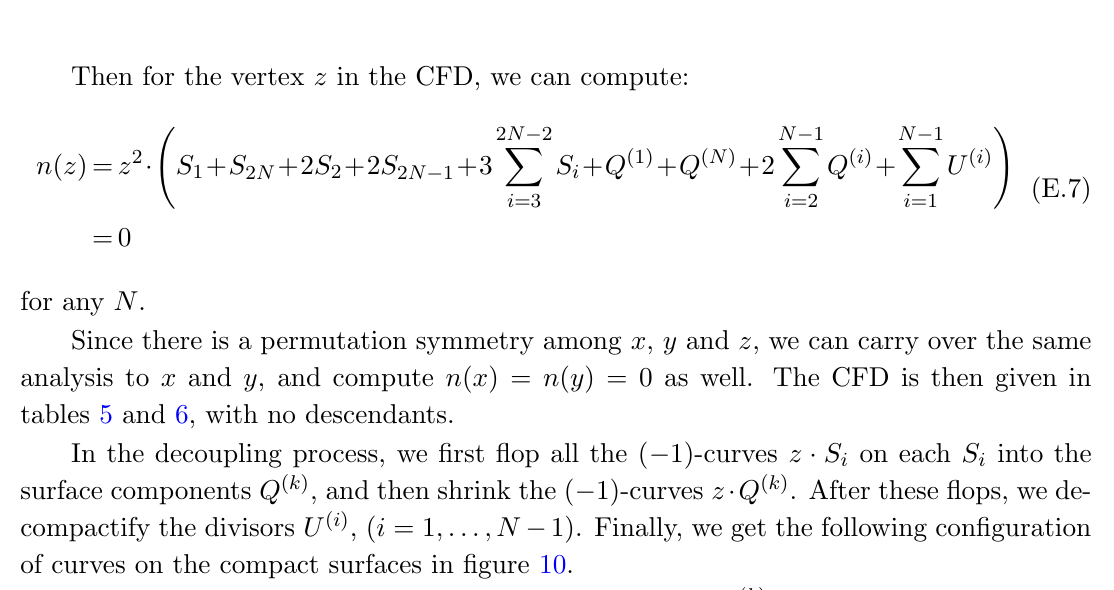
Figure 9. The con(cid:12)guration of curves in the KK resolution geometry of non-minimal ( E 6 ; E 6 ) conformal matter with order N